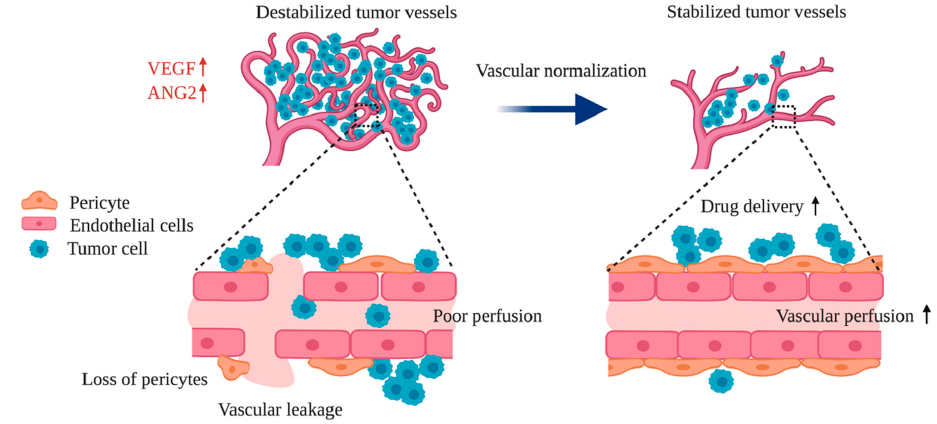
Figure 1. Vascular destabilization and normalization in the tumor microenvironment. Vascular endothelial growth factor-A (VEGF) and angiopoietin-2 (ANG2) levels are upregulated in the tumor microenvironment where vessels are functionally and structurally altered. Destabilized tumor vessels are characterized by pericyte loss, impaired endothelial junctions, increased vascular leakage and